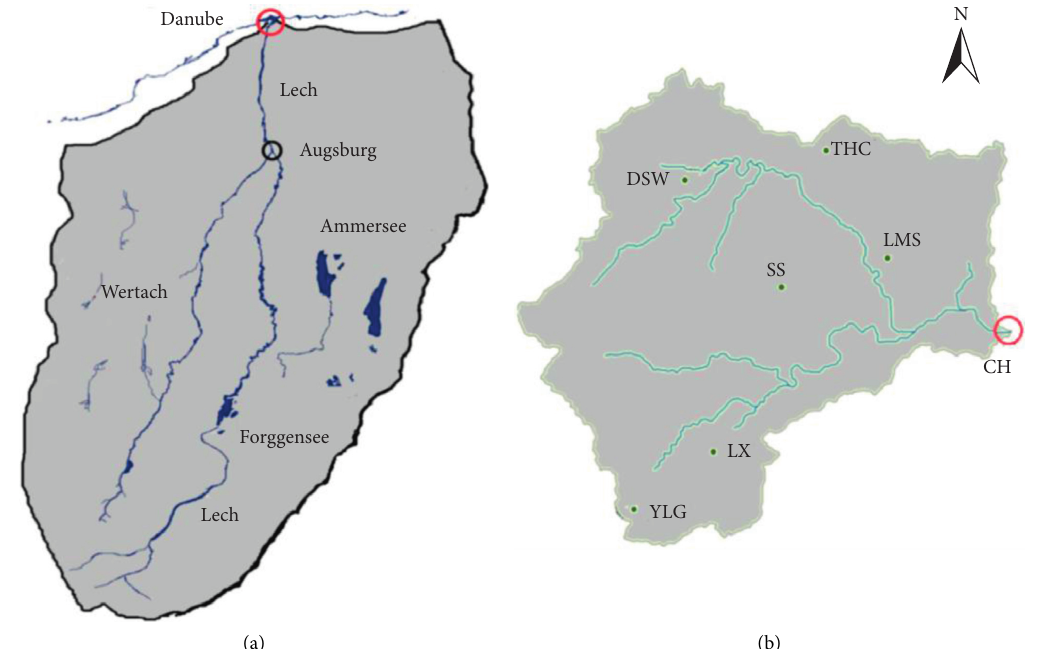
Figure 1: Illustration of Lech (a) and Changhua (b) river basins, where we need to predict flow rate values of converge locations labeled by red circles.